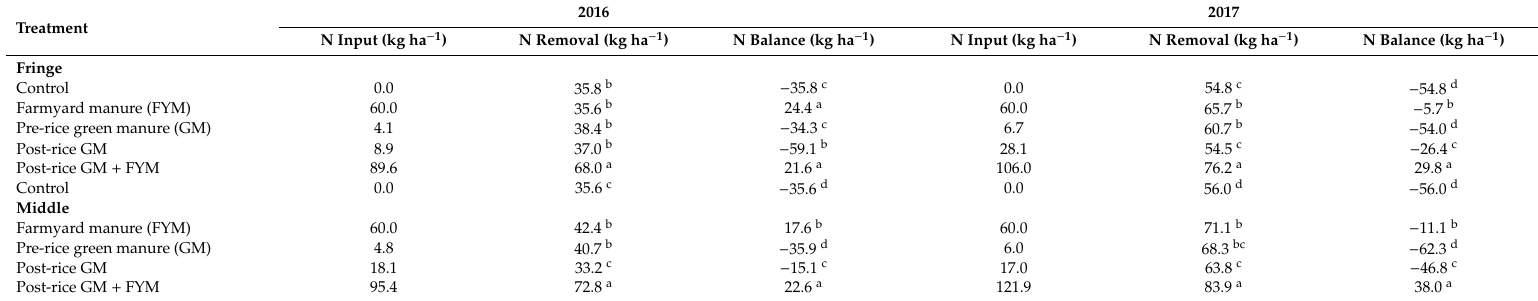
Farmyard manure (FYM) 60.0